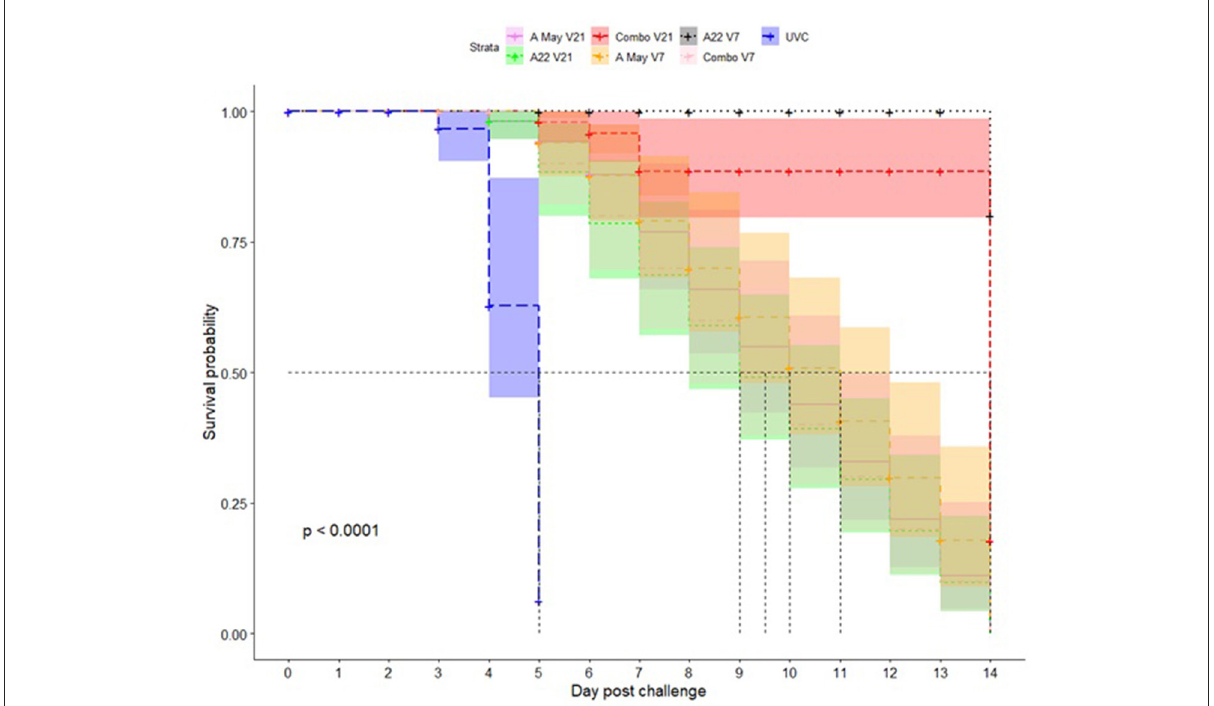
FIGURE2 Kaplan-Meier survival plots for protection against A/TAI/15/2013 virus in pigs vaccinated with A May 97 and A22 Iraq 64 vaccines in monovalent or combination formulations. The x-axis represents time in days, and the y-axis shows the probability of surviving or the proportion of pigs surviving the virus challenge post-vaccination in different vaccine groups. The lines represent survival curves of the seven vaccine groups (Vaccine = 1: A May V21; Vaccine = 2: A22 V21; Vaccine = 3: Combo V21; Vaccine = 4: A May V7; Vaccine = 5: A22 V7; Vaccine = 6: Combo V7; Vaccine = 7: UVC). A vertical drop in the curves indicates an event (pigs showing clinical signs of FMD). The vertical tick mark on the curves means that a pig was censored at this time.